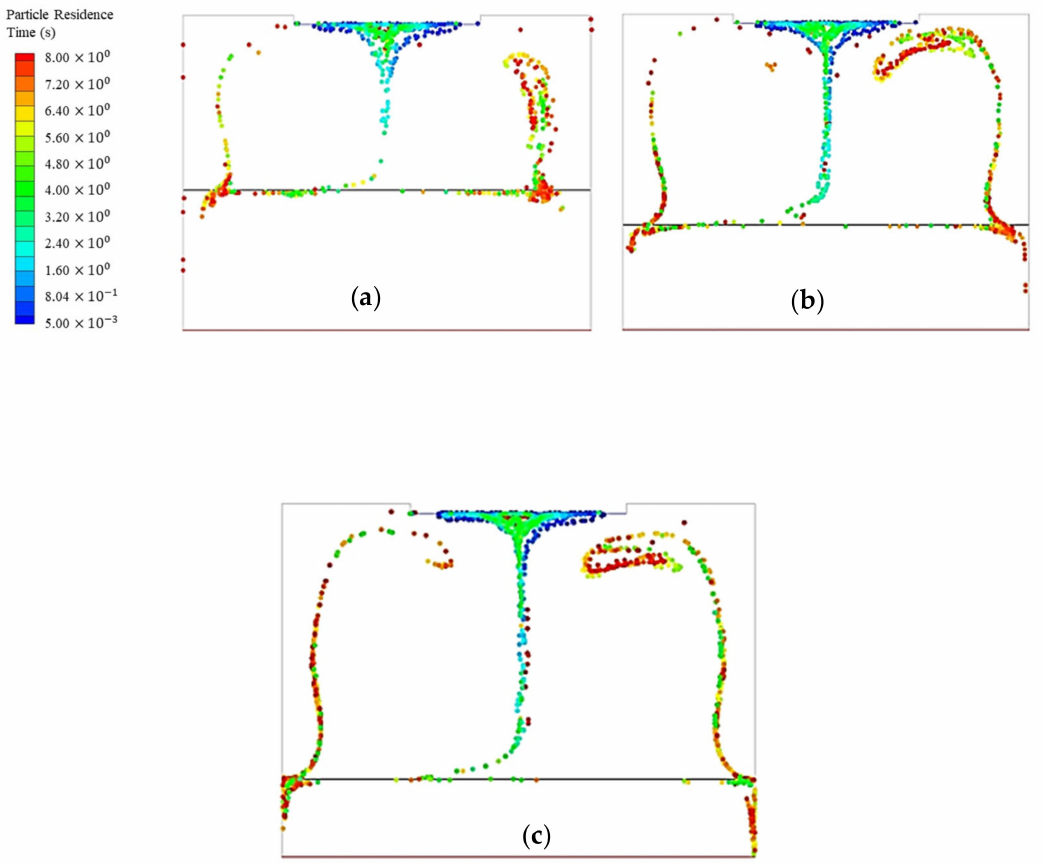
Figure 11. Inclusions distribution with different slag layer thickness ( a ) 50 mm ( b ) 60 mm and ( c ) 70 mm.